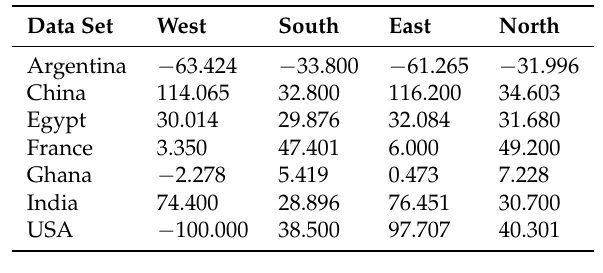
Table A1. Coordinates of all seven considered datasets. The reference system is WGS 84, the coordinates are given in decimal degrees.